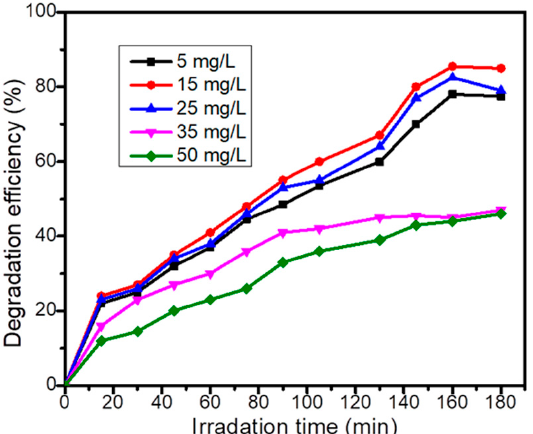
Figure 5. Effect of initial concentration of amoxicillin on photocatalytic degradation (pH = 9, cata- lyst dose = 1 g/L) . dose = 1